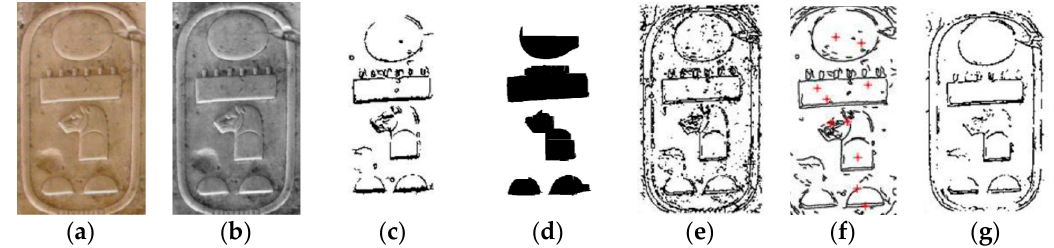
Figure 1. ( a ) Original image; ( b ) Monochrome image; ( c ) Sobel edge detection; ( d ) regions by frontier; ( e ) SUSAN algorithm; ( f ) Circle Hough Transform to obtain most-probable circles; ( g ) curvature salience after 20 iterations.